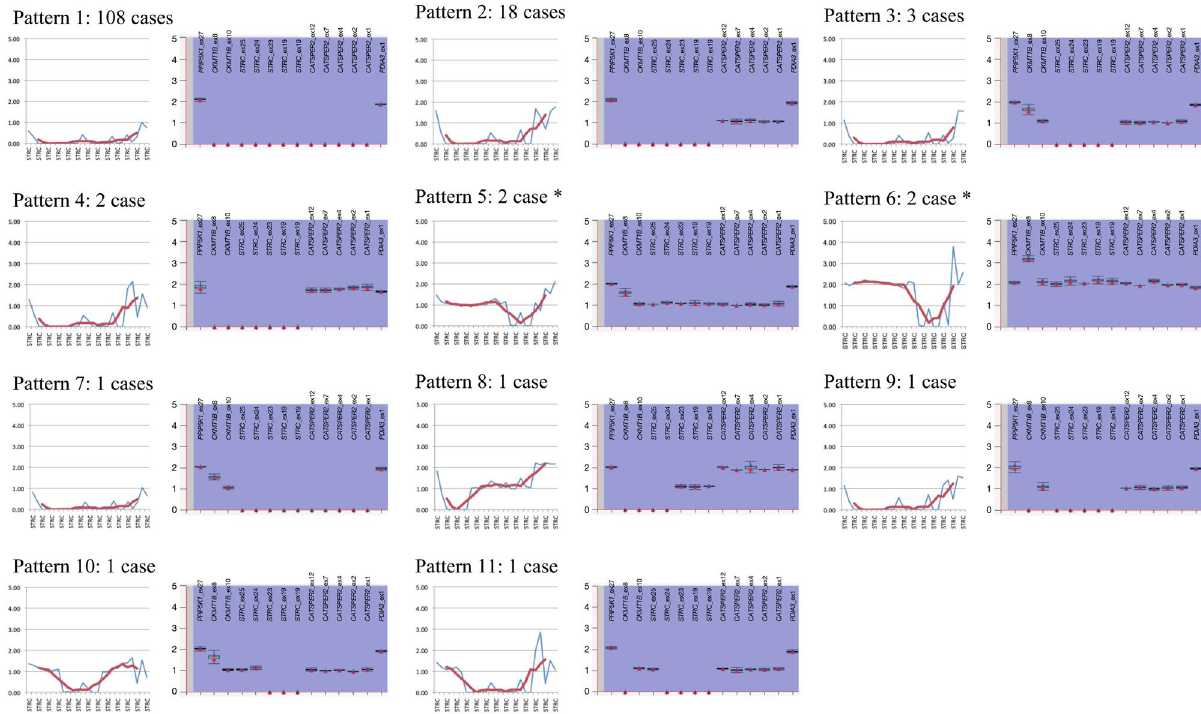
Figure 2. Types of homozygous STRC gene deletion identified by MLPA analyses. In this study, we identified 11 types of CKMT1B-STRC-CATSPER2 gene deletion by NGS and MLPA analyses. NGS-based CNV analysis (left) was performed in accordance with our previous report 22 . Blue indicates the estimated copy number for each amplicon and red indicates the smoothing value for five relative amplicons. The vertical axis shows the copy number for each amplicon. MLPA (right) was performed using a commercially available MLPA probe (SALSA MLPA Probe mix P461-A1; MRC-Holland, Amsterdam, Netherlands). Box plots and error bars indicated the estimated copy number range and standard deviation for each MLPA probe, respectively. The vertical axis shows the copy number for each probe and the horizontal axis indicates the probes used in the MLPA analysis. *The MLPA probe set used in this study was only designed for exons 19, 23, 24 and 25 of the STRC gene and